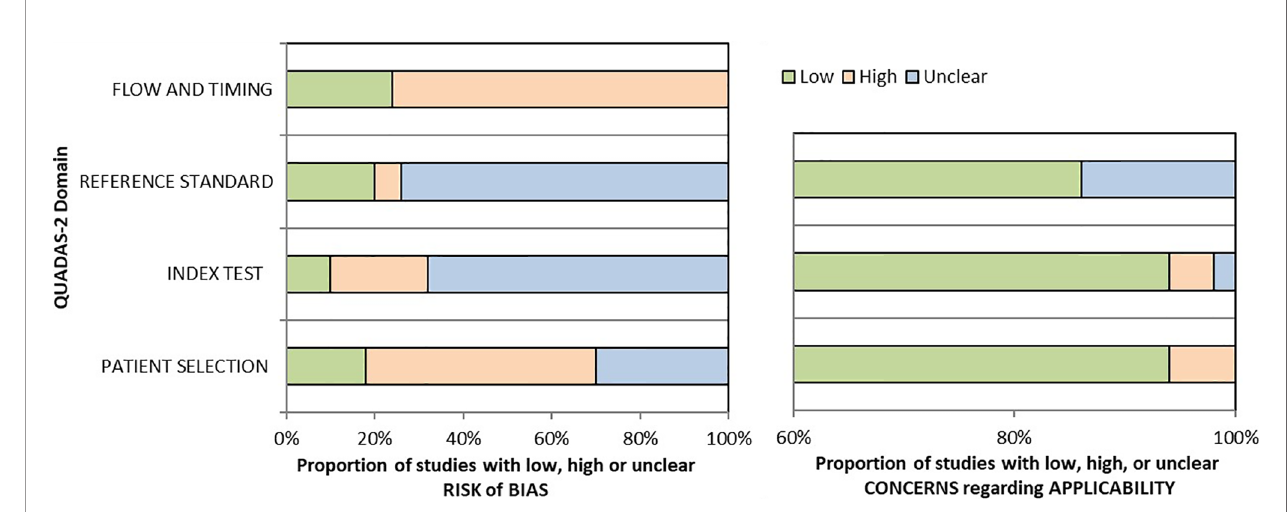
FIGURE 2 | Graphical summary for risk of bias and applicability concerns using the QUADAS-2